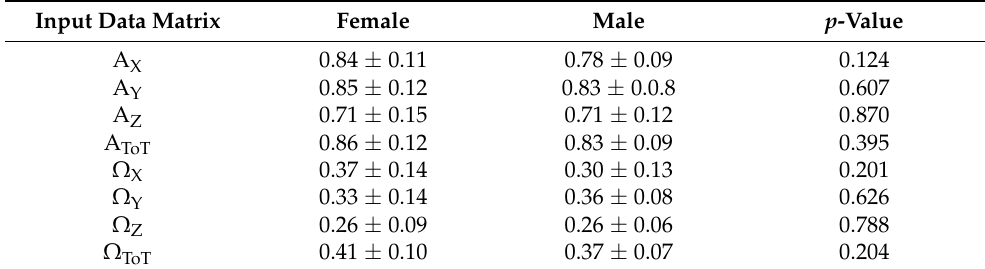
Table 3. Pearson correlation coefficient between best-matching retained PCs and V RC (mean ± standard deviation). The p -value is the outcome of the unpaired t -test comparing the effect of the factor gender on the independent variables. The p -values are highlighted in bold when reaching significance ( p < 0.05).